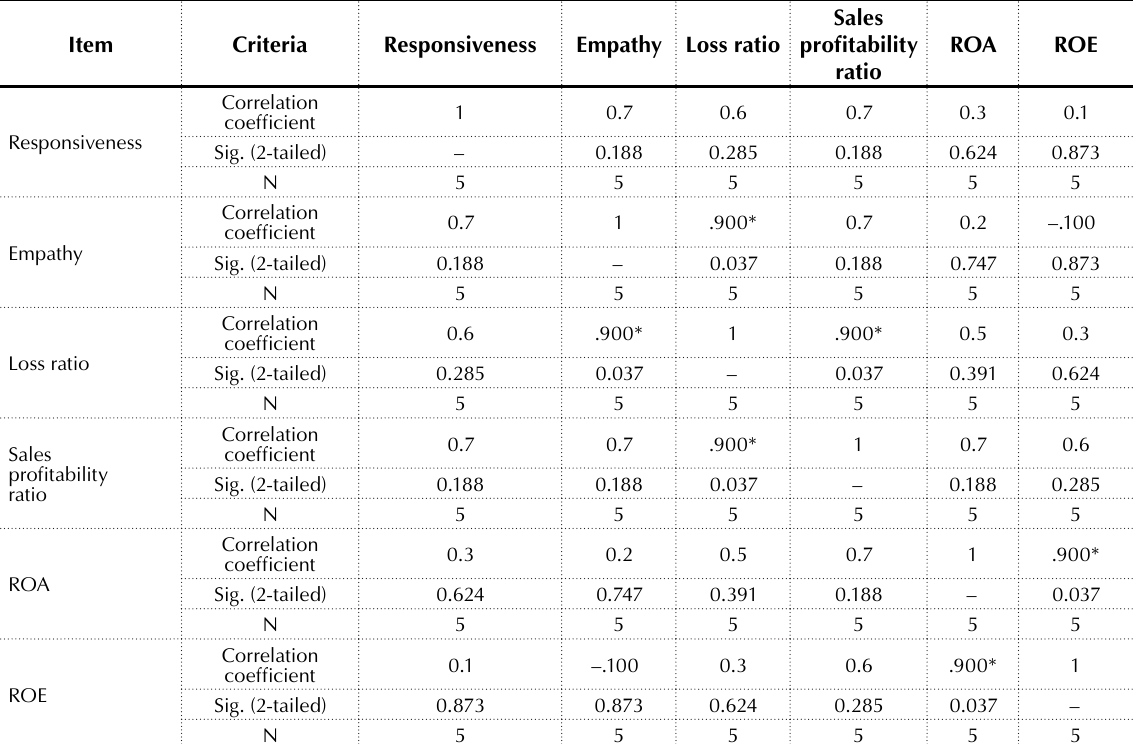
Table A8. Correlation between SERVQUAL and profitability